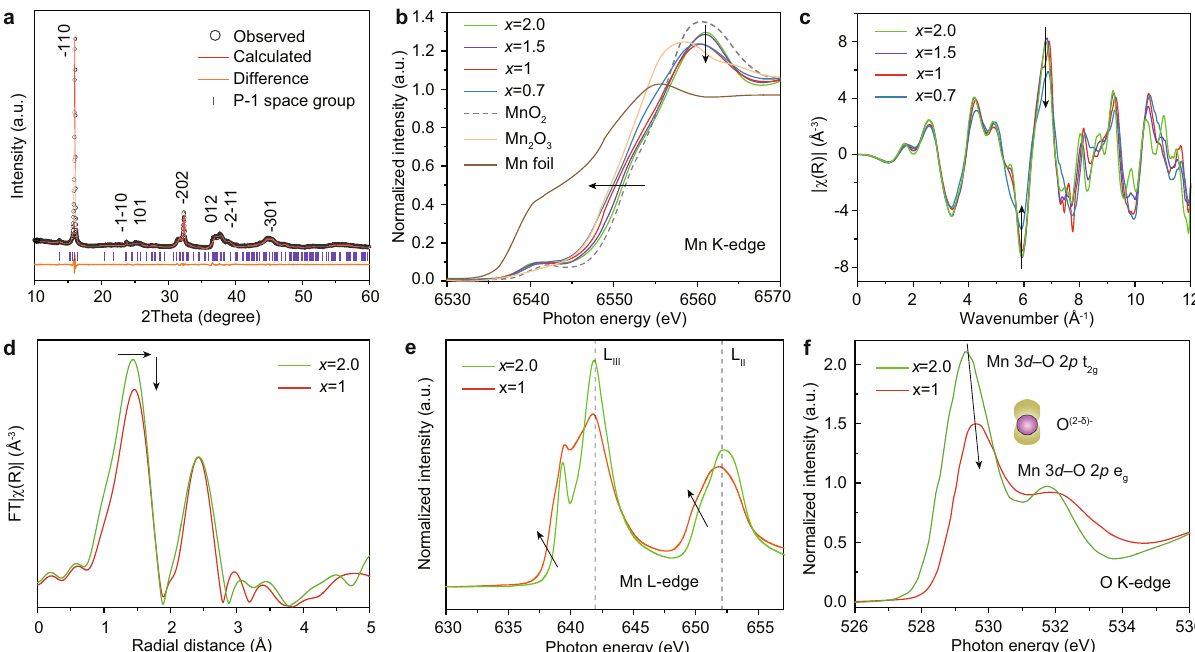
Fig. 3 Electronic and atomic coordination structures of Na x Mn 3 O 7 . a XRD pattern of Na 2 Mn 3 O 7 . Normalized Mn K-edge XANES spectra ( b ) and EXAFS oscillation functions ( c ) of Na x Mn 3 O 7 ( x = 2.0, 1.5, 1.0 and 0.7). d Fourier transform magnitudes of Mn K-edge EXAFS k 2 χ ( k ). Mn L 2,3 -edge ( e ) and O K pre-edge ( f ) of soft XAS spectra of Na 2 Mn 3 O 7 and NaMn 3 O 7